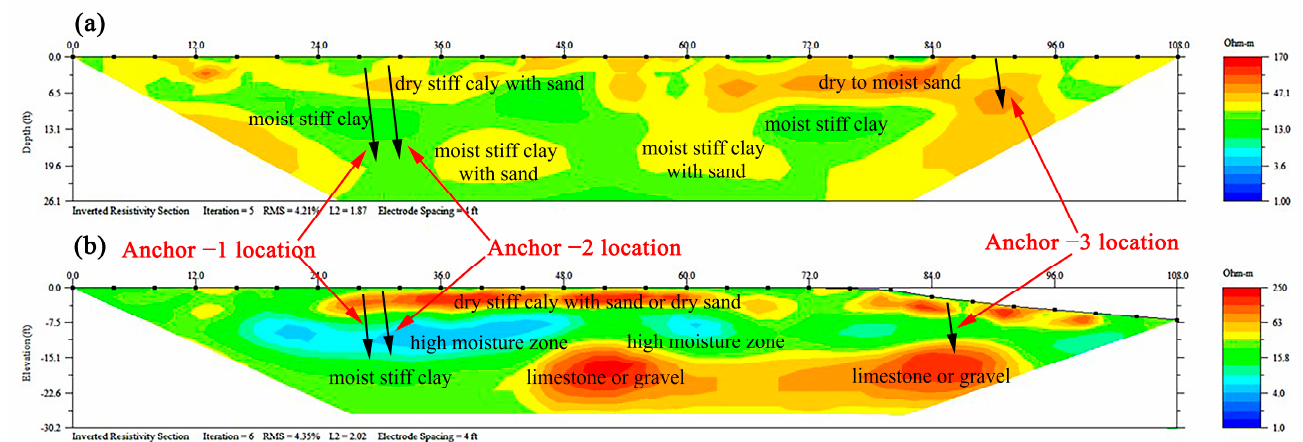
Figure 7. Inverted resistivity profiles from the ERI test at the west bank: ( a ) inverted resistivity profile from ERI line at the crest of the west bank slope; ( b ) inverted resistivity profile from ERI line at 36 m behind the crest of the slope.